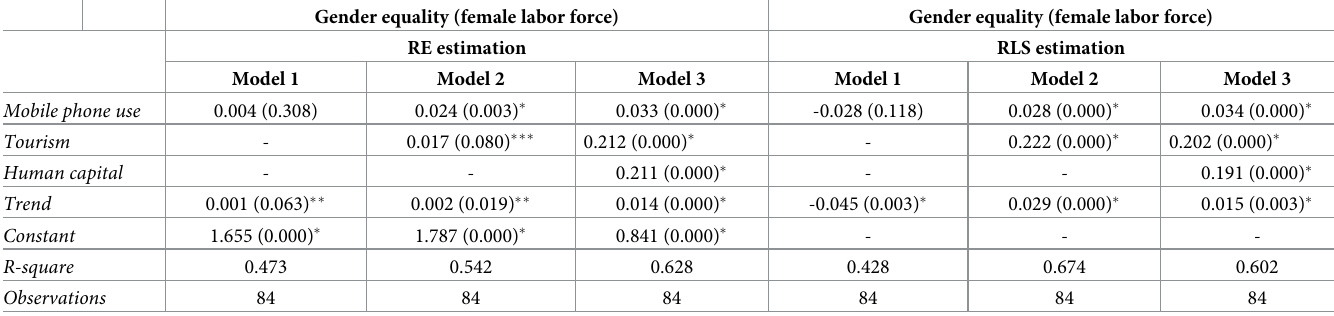
Table 6. Results of ICT and gender (female labor